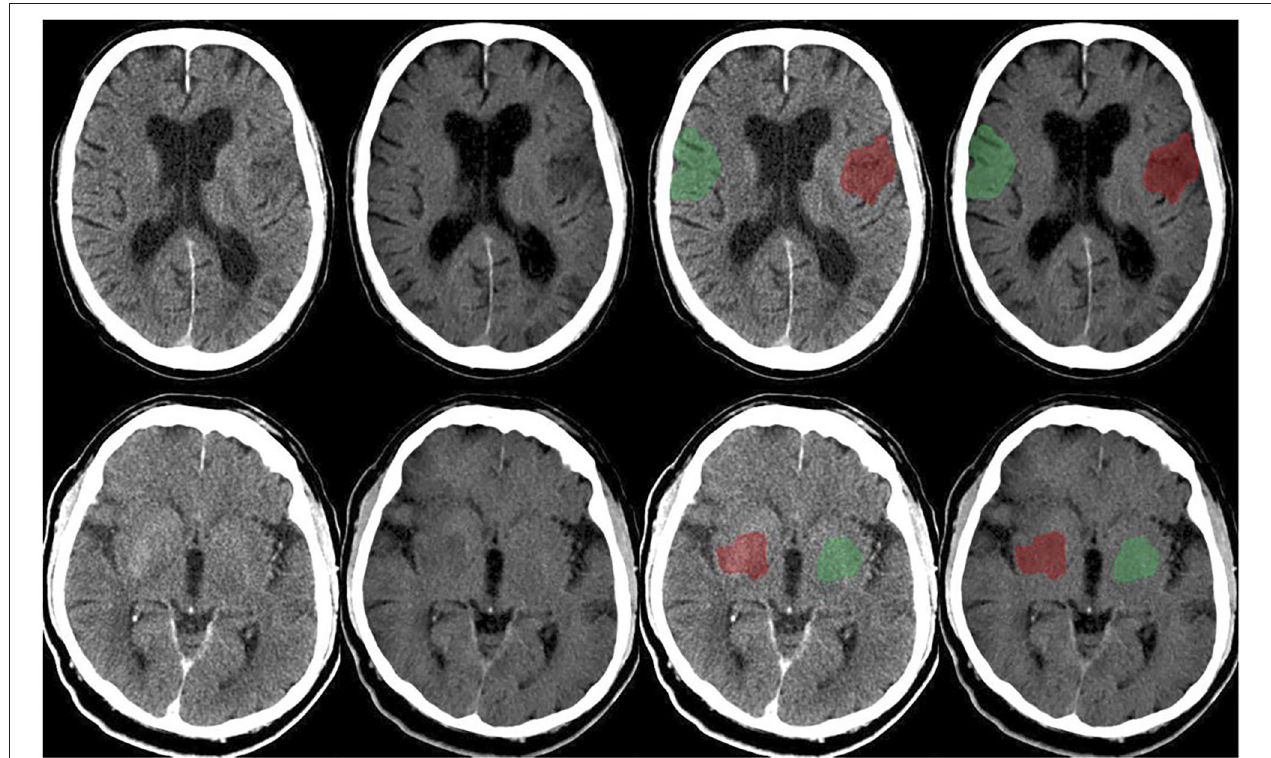
FIGURE 1 | Upper row: Follow-up dual-layer dual-energy CT within 12h in a 70-year-old man with left MCA occlusion (initial NHISS 7; ASPECTS 8) after thrombectomy (TICI 3), time onset to reperfusion 184min. Conventional polychromatic image (first and third from the left), VNC image (second and fourth from the left). Example of ischemic ROI placement (red) and contralateral normal ROI placement (green). Lower row: Follow-up dual-layer dual-energy CT within 12h in an 89-year-old man with right MCA occlusion (initial NHISS 17; ASPECTS 8) after thrombectomy (TICI 3), time onset to reperfusion 154min. Conventional polychromatic image (first and third from the left), VNC image (second and fourth from the left). Example of ischemic ROI placement (red) and contralateral normal ROI placement